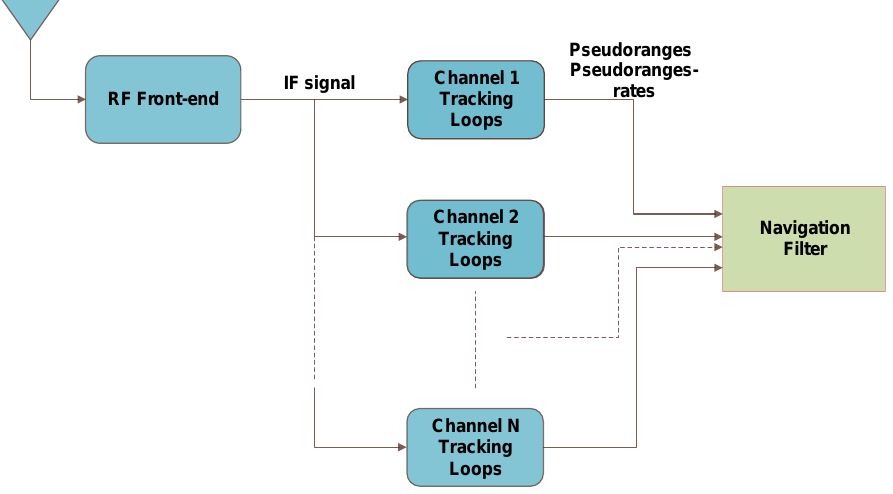
Figure 1. A Block Diagram of Scalar Tracking Systems.